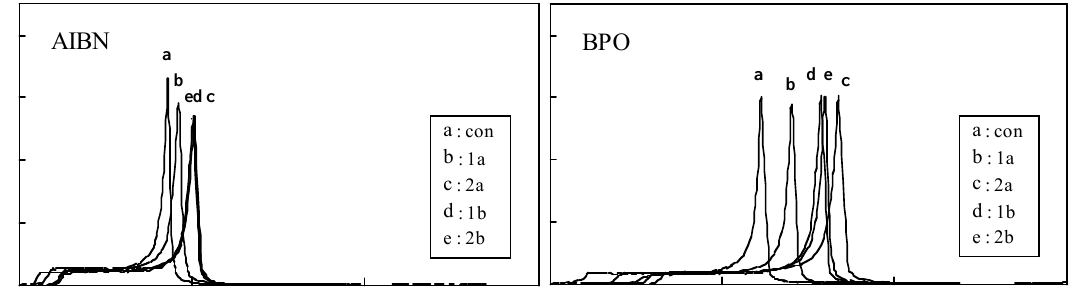
Figure 2. Typical exothermic and time-conversion curves for the polymerization of MMA with AIBN or BPO in the presence of 0.01mol % additives.